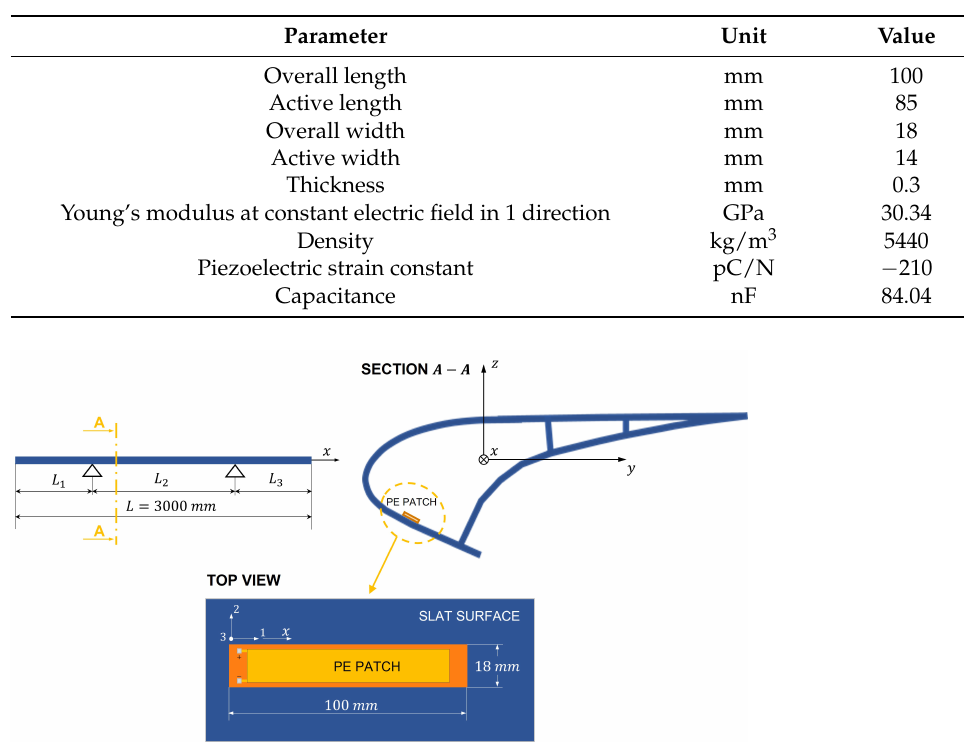
Table 1. Electromechanical properties of the PE patch MFC-8514-P2, from datasheet provided by Smart Material Corp.